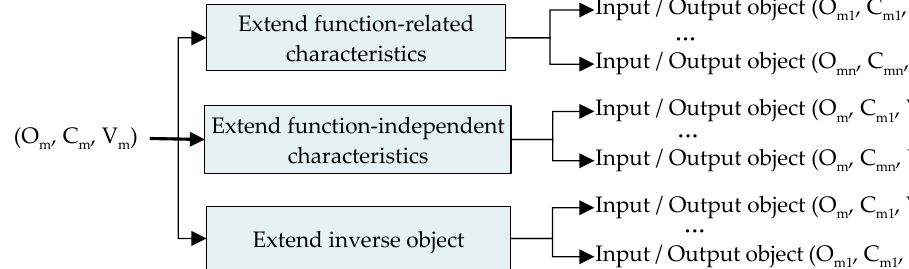
Figure 5. Model for extending the action object based on the divergence tree.